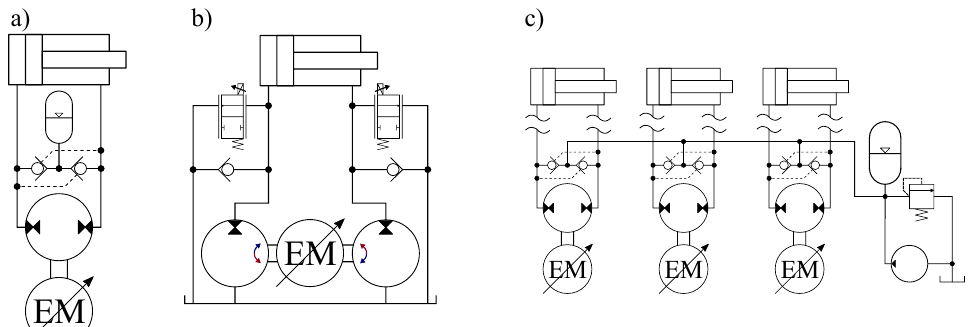
Figure 4. Simplified schematics of considered EHA types ( a ) compact single pump ( b ) compact dual pump according to [13] and ( c ) single-pump